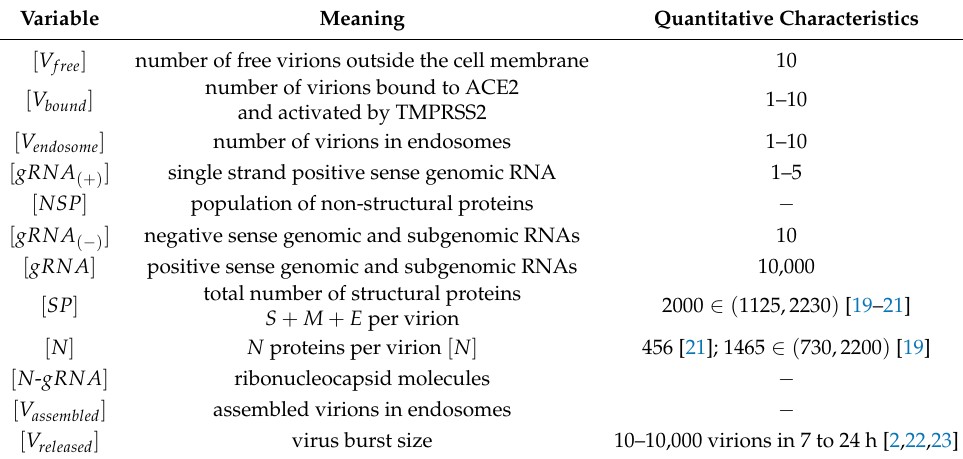
Table 1. Time-dependent variables of the mathematical model characterizing the SARS-CoV-2 life